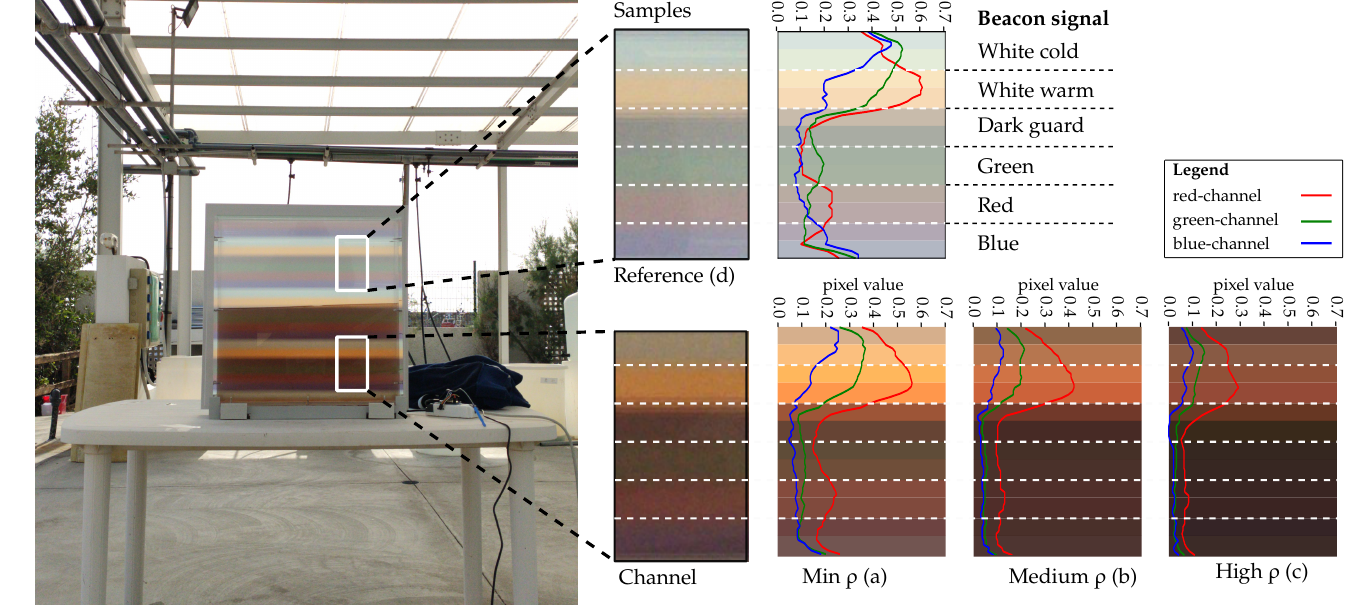
Figure 11. Experimental transmission of a well-known beacon